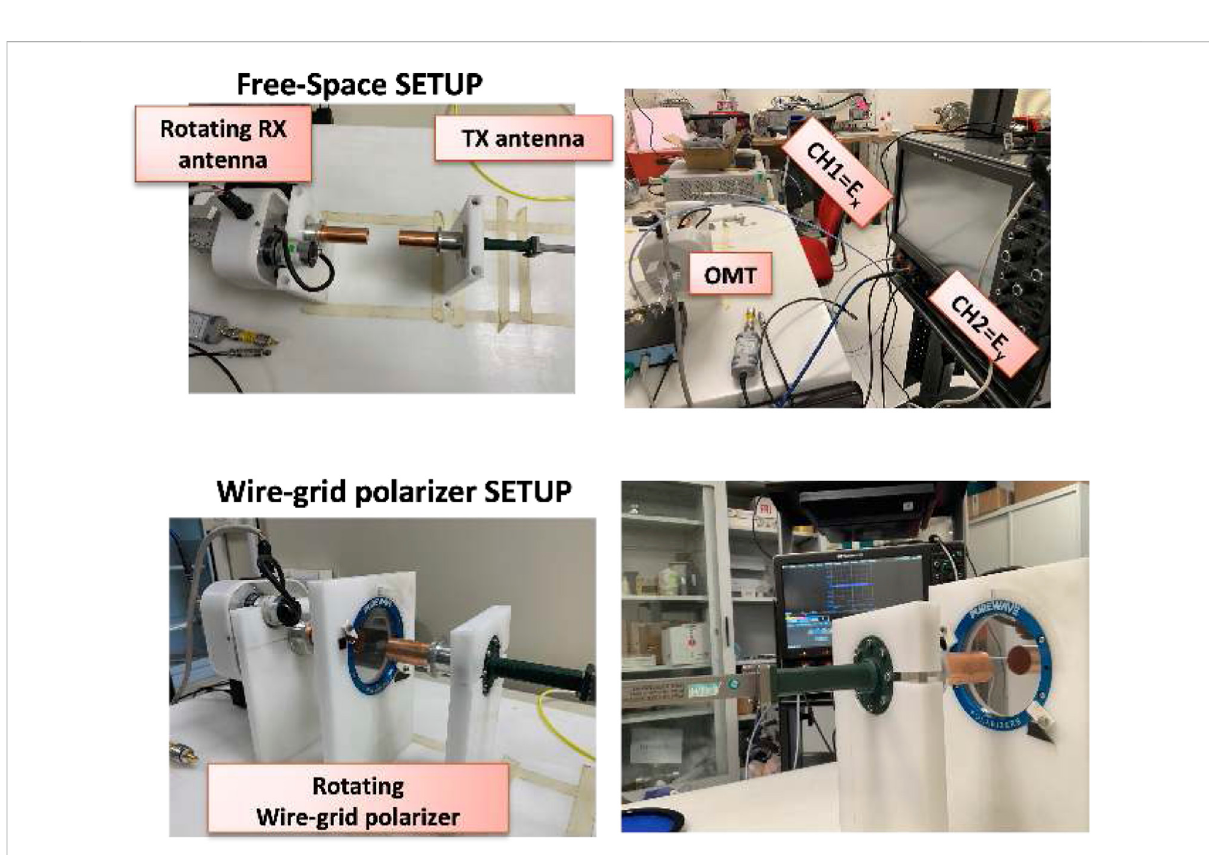
FIGURE 8 Photographs of the Free-space testbench showing the two Ka-band conical horn antennas, the OMT, the wire-grid polarizer and the 20 GHz 80 GS/s (40 Gs/s in this case since the detection is performed on the two channels, simultaneously)